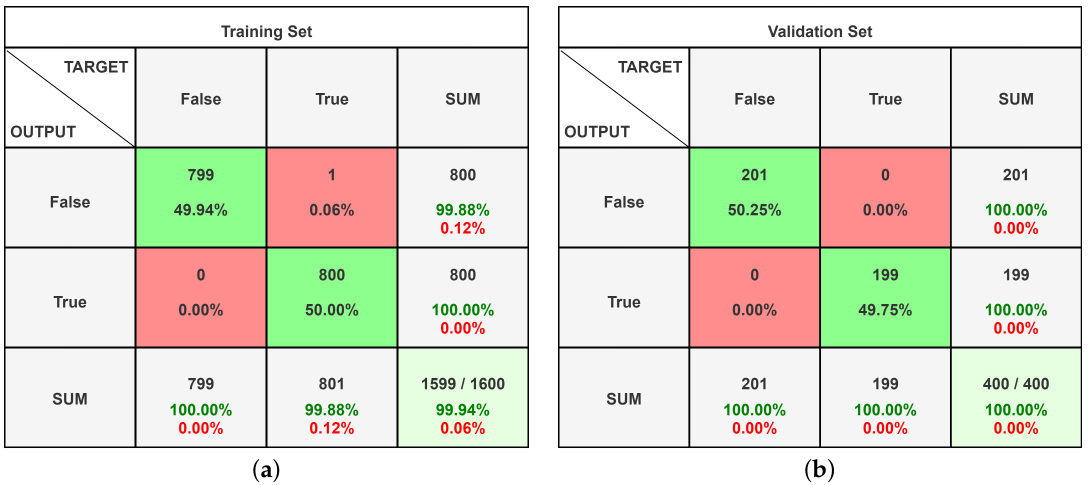
Figure 7. Confusion matrices of the men at sea dataset analysed on InceptionResNet-V2 with Google Colab. ( a ) Training set confusion matrix; ( b ) validation set confusion